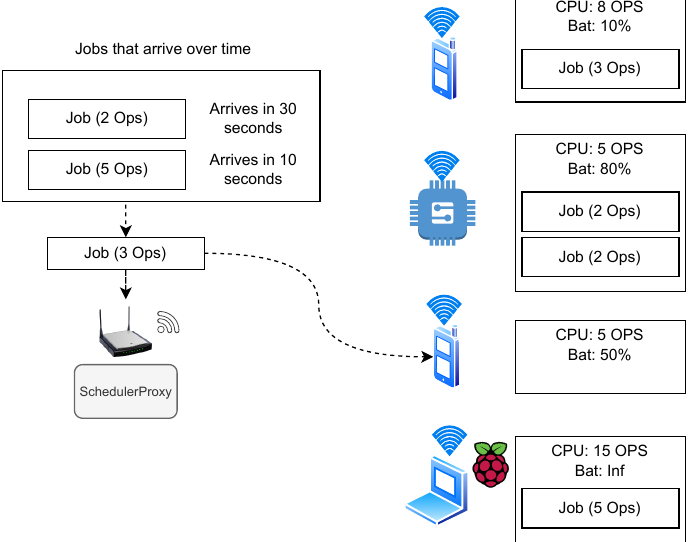
Figure 2. Overview of a scheduling problem in a Dew environment. Jobs arrive over time to the scheduler. Once a job arrives, the scheduler must assign that job to a device connected to the local network. In order to make such a decision, the scheduler has access to information about the job and the state of each device connected to the network. More details can be found in Section